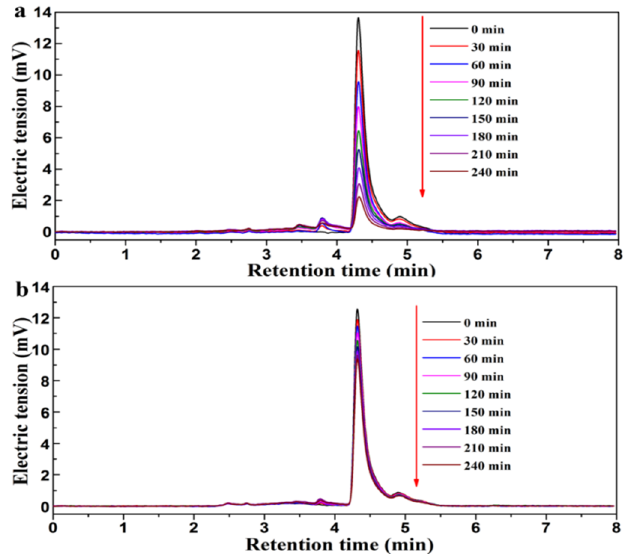
Figure 7. SMT degradation peaks obtained by high pressure liquid chromatography (HPLC) mediated by ZnO/Cu x = 1.25 O %) nanowires under ( a ) simulated solar light irradiation and ( b ) visible light irradiation. Solution parameters: Solution parameters: [catalyst] = 500 mg/L, [SMT] = 2.5 mg/L, initial pH 7.0.